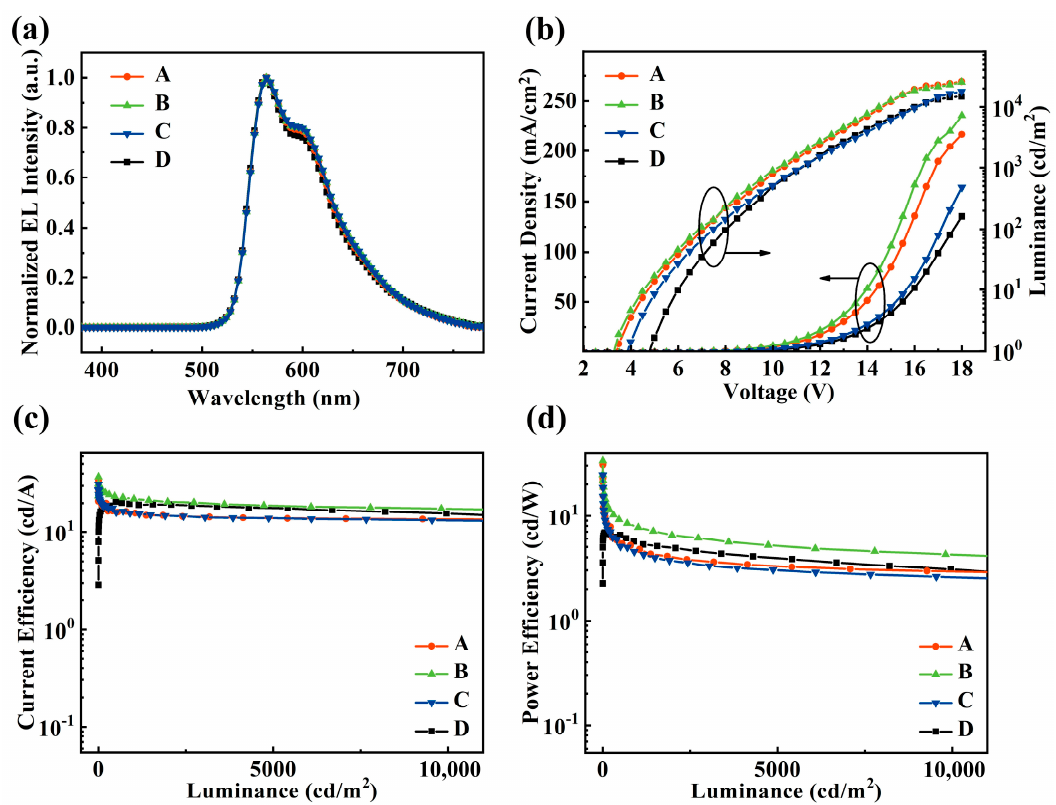
Figure 2. ( a ) The normalized electroluminescence (EL) spectra of devices A–D at 9 V; ( b ) the